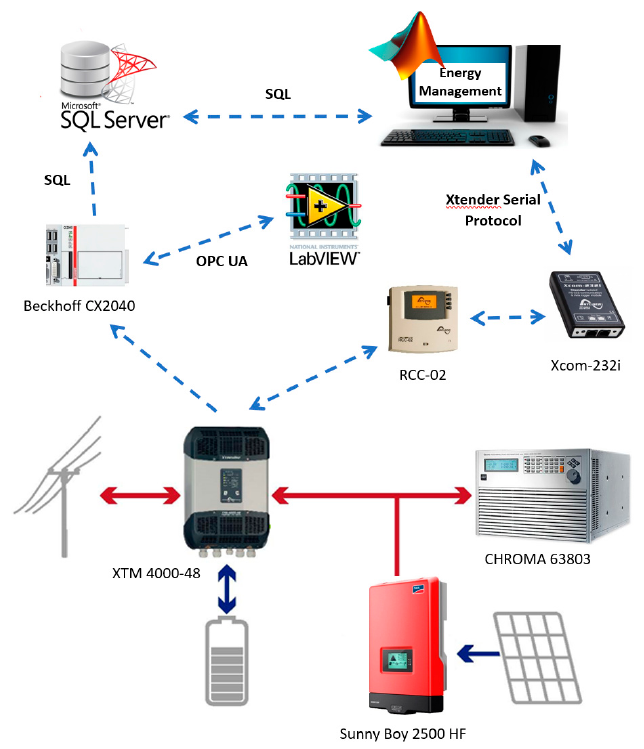
Figure 7. Experimental